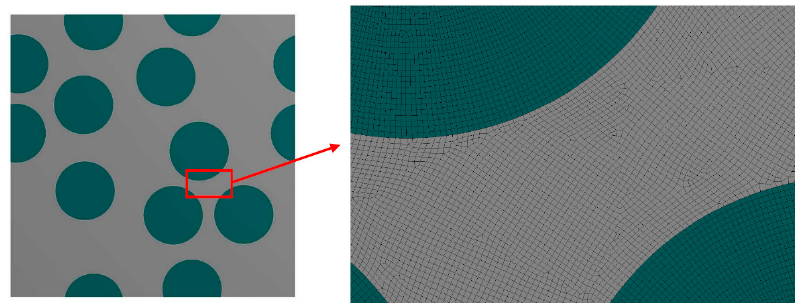
Figure 6. Finite element mesh discretizing the microgeometry. Table 1. Material Properties of the Composite Constituents.